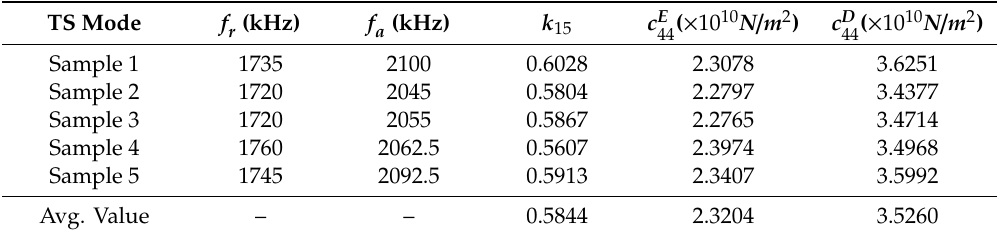
Table 3. Resonant and anti-resonant frequencies and the converted material constants in thickness shear extension (TS)